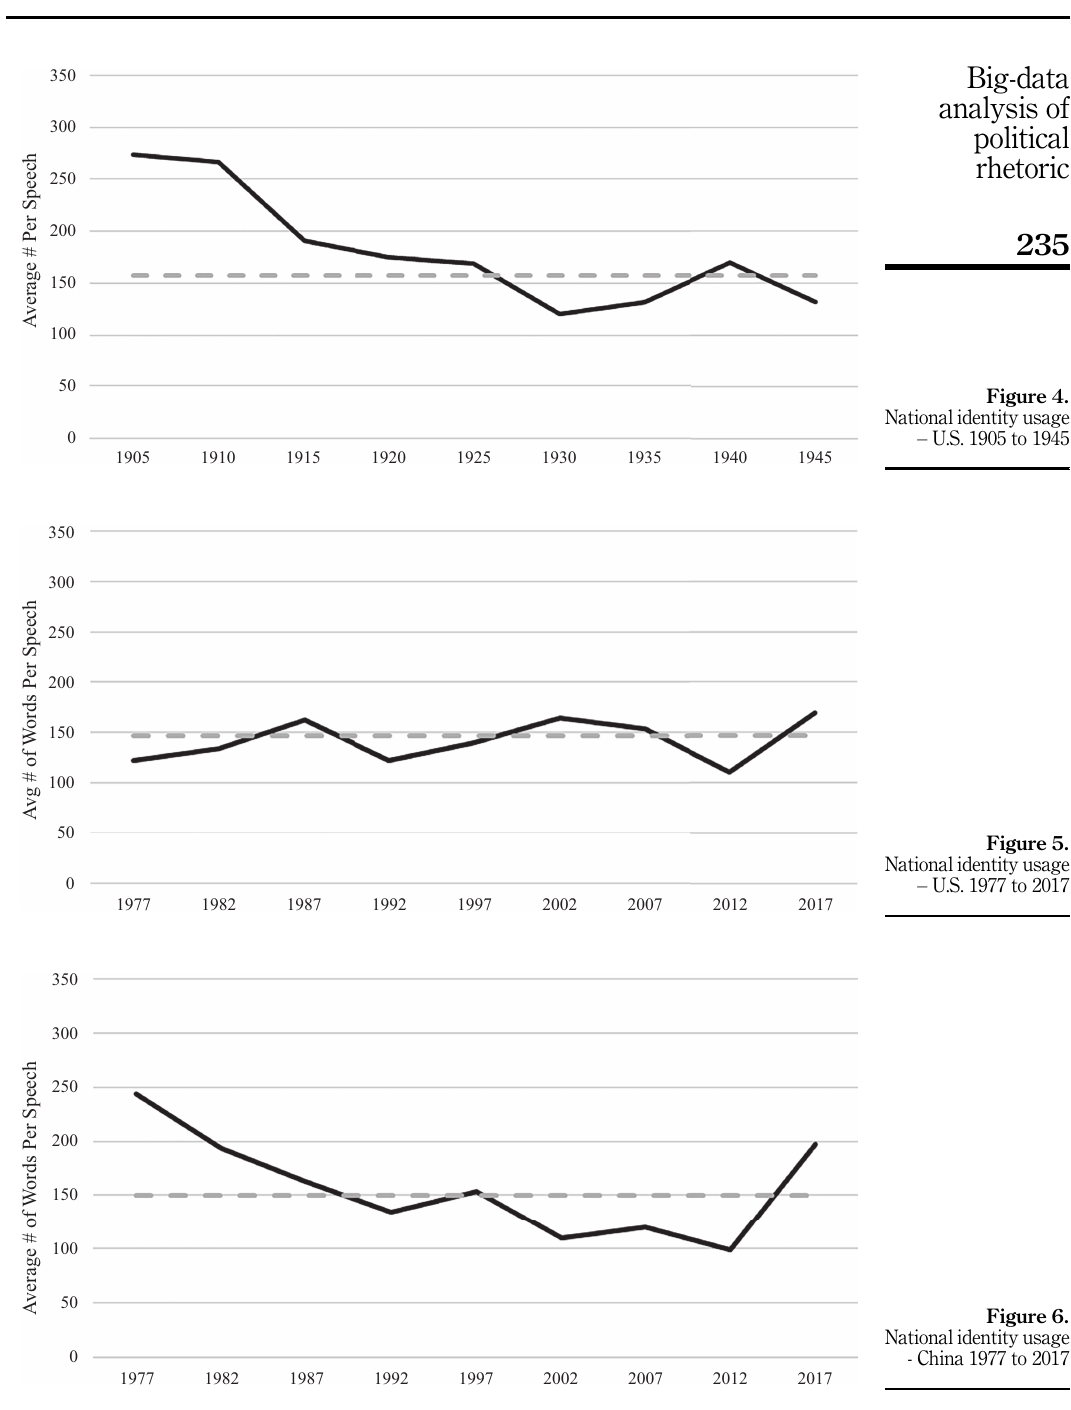
Figure 6. National identity